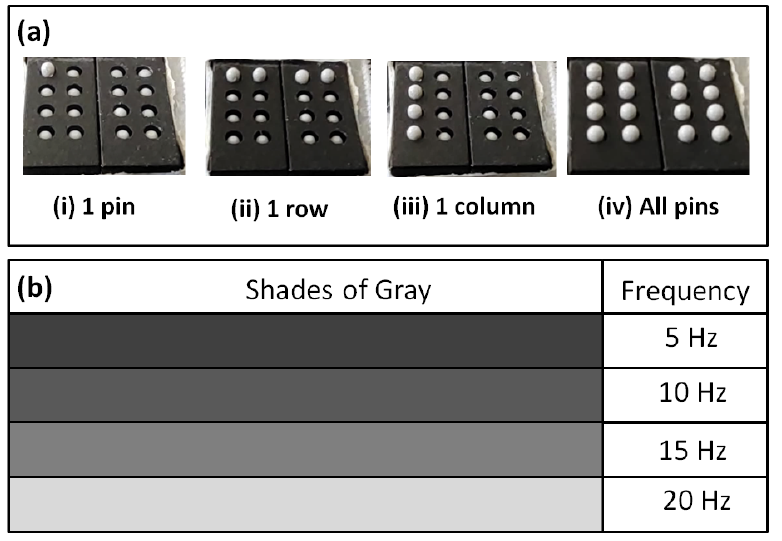
Figure 12. Tapping vibration. ( a ) Tapping vibration can be achieved using ( i ) 1 pin, ( ii ) 1 row, ( iii ) 1 column, and ( iv ) all pins. ( b ) Different tapping frequencies can be assigned to various shades of